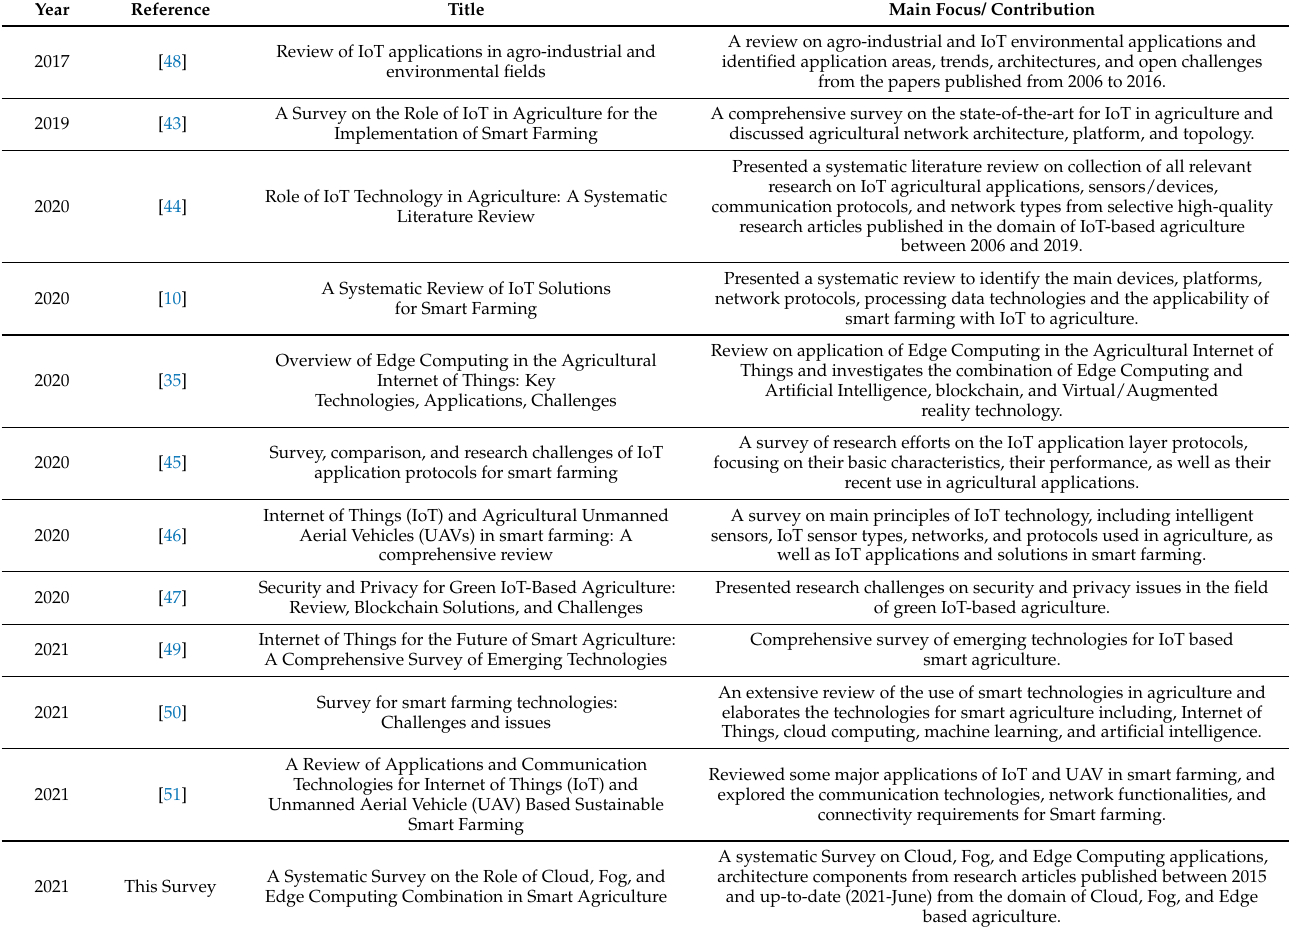
Table 2. Review/Survey Papers and their